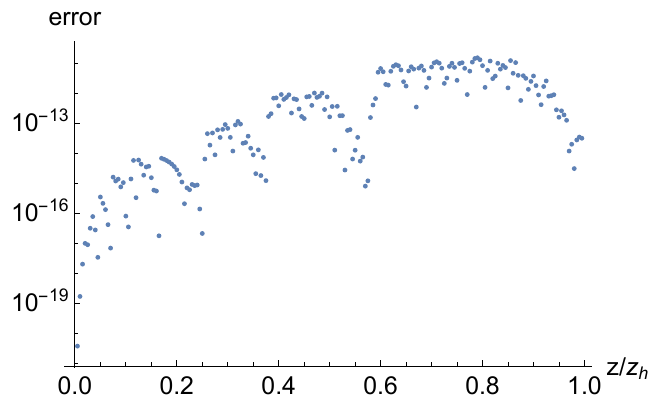
Figure 15 . Example of the numerical value accepted for the l.h.s. of A.9 at (cid:22)=T = 4, (cid:21) = 1 and (cid:11) 3 =T =